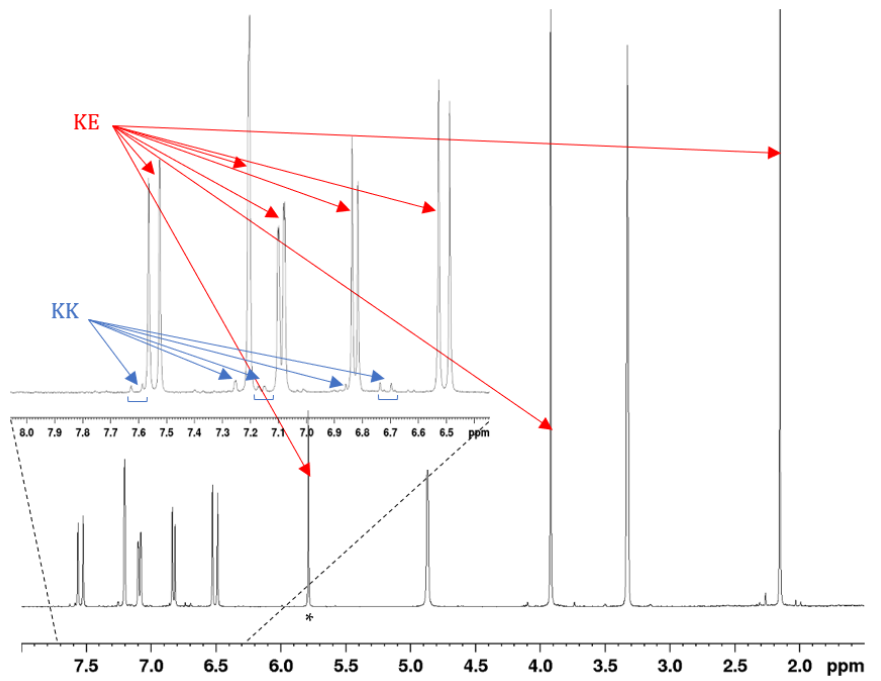
Figure 4. 1 H NMR spectrum of compound 1 in MeOD- d 4 at 298 K (at 600 MHz). Blue and red arrows highlight the KK end KE tautomeric forms, respectively. * Enol vinyl signal.